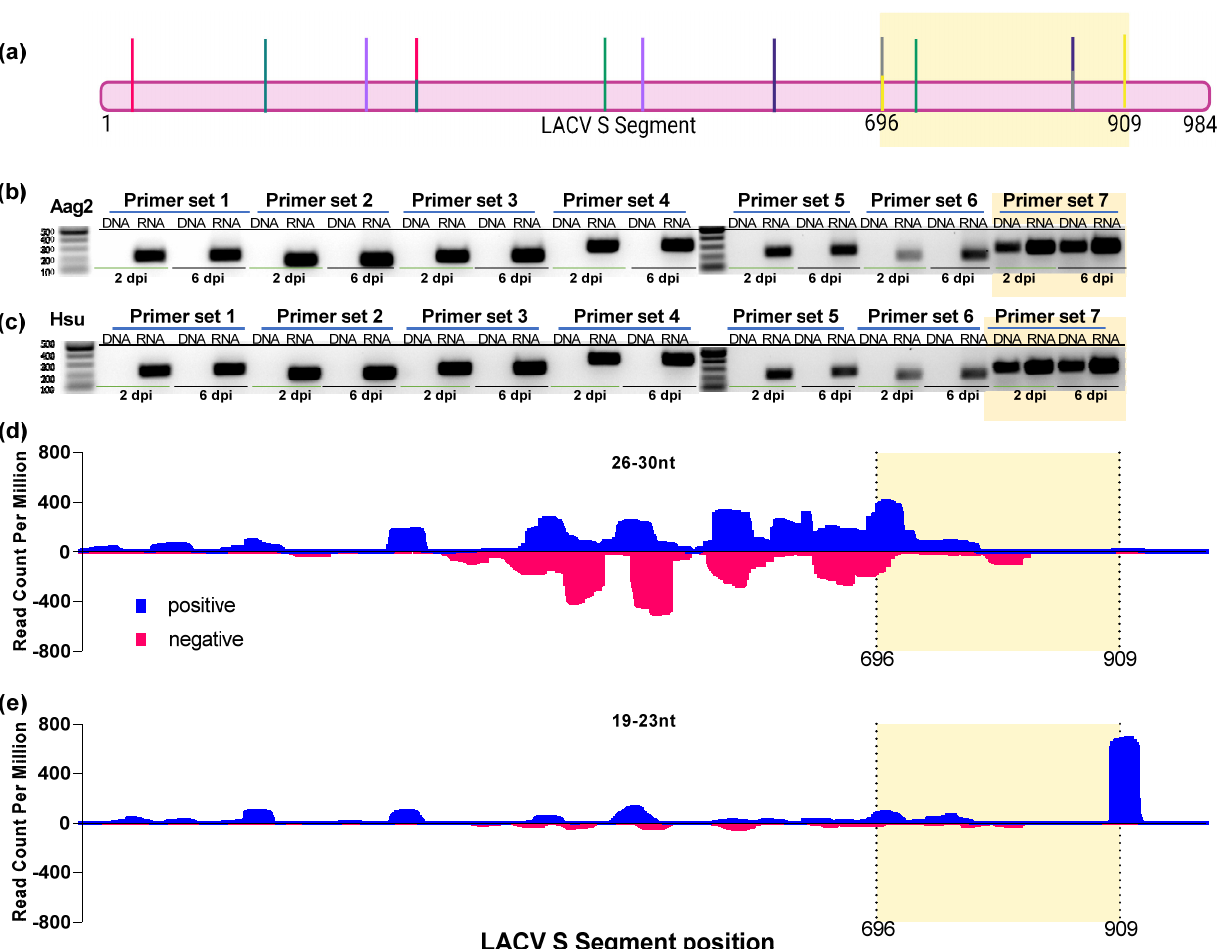
Figure 10. Generation of viral DNA forms in mosquito cells following LACV infection. PCR was performed using genomic DNA, and cDNA from LACV-infected Aag2 and Hsu cells. ( a ) Overlapping primer sets covering the LACV S segment were designed. Colors indicate primer pairs used to amplify specific regions. ( b ) PCR products from Aag2 LACV-infected cells at 2 dpi or 6 dpi. ( c ) PCR produced from Hsu LACV-infected cells at 2 dpi or 6 dpi. ( d ) Positional mapping of LACV-derived piRNAs along the LACV S segment. ( e ) Positional mapping of LACV-derived 26–30 nt ( d ) and 19–23 nt ( e ) sRNAs along the LACV S segment. Yellow highlighted regions ( a – e ) indicate where LACV vDNA was produced.